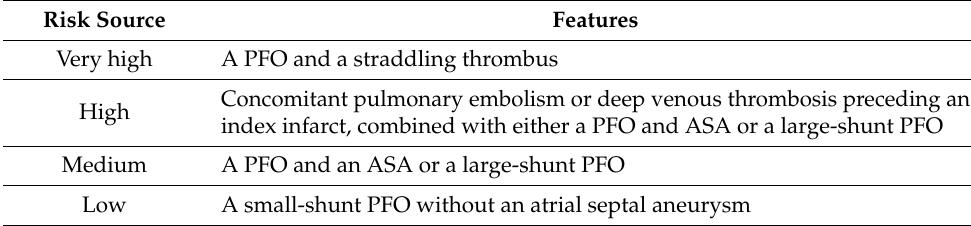
Table 2. Pascal classification (adapted by Kent